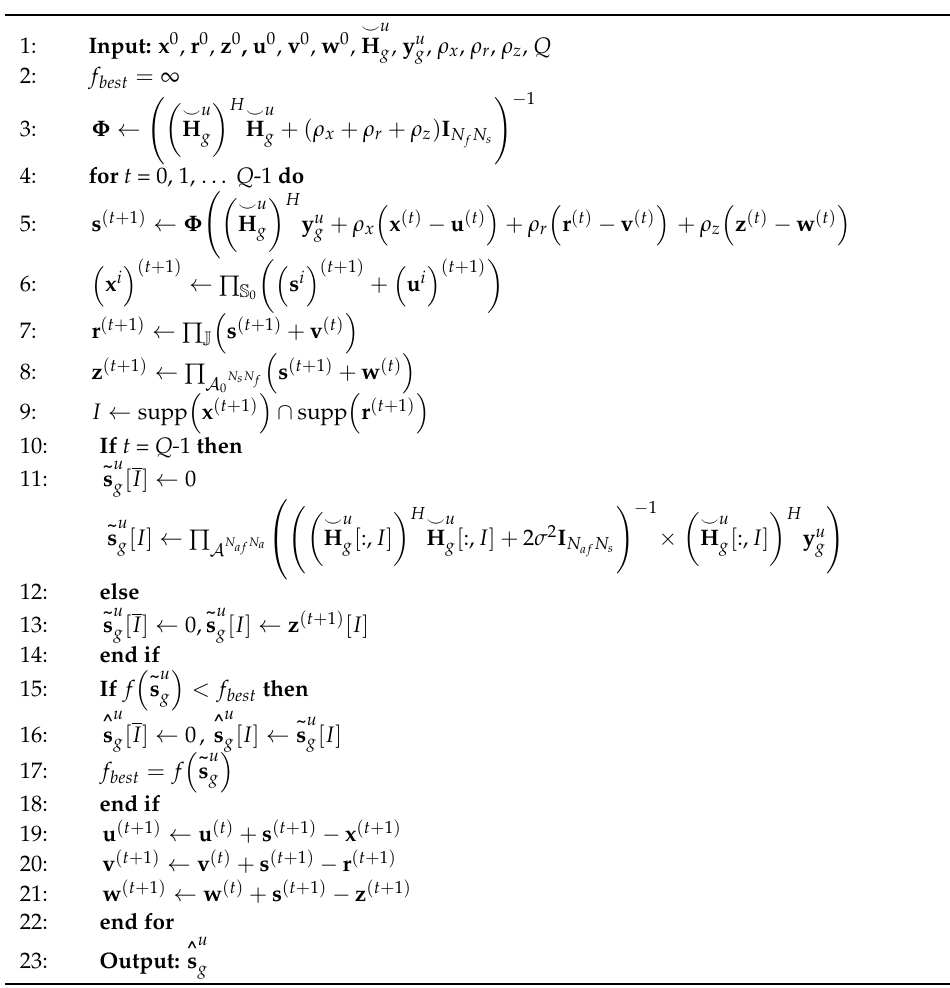
Table 1. Algorithm based in ADMM used for GSFIM detection